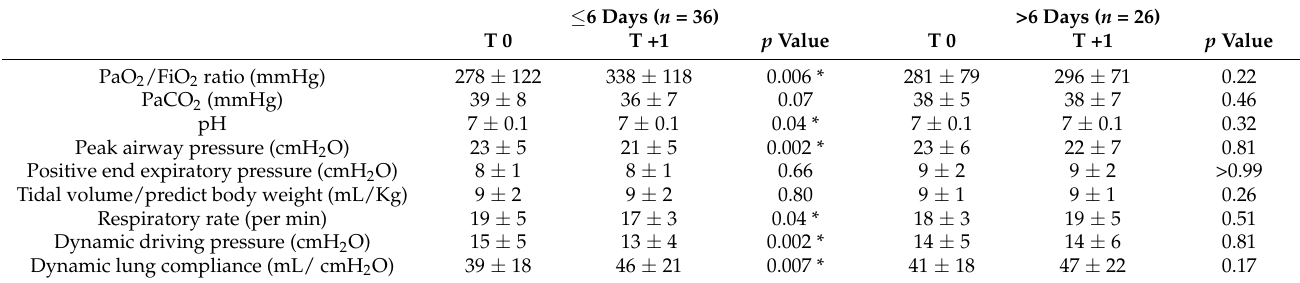
Table 4. Changes in arterial blood gas parameters and respiratory mechanics before and after ultrasound-guided pleural effusion drainage in patients with the time interval from the onset of pleural effusion to pleural effusion drainage ≤ 6 days or >6